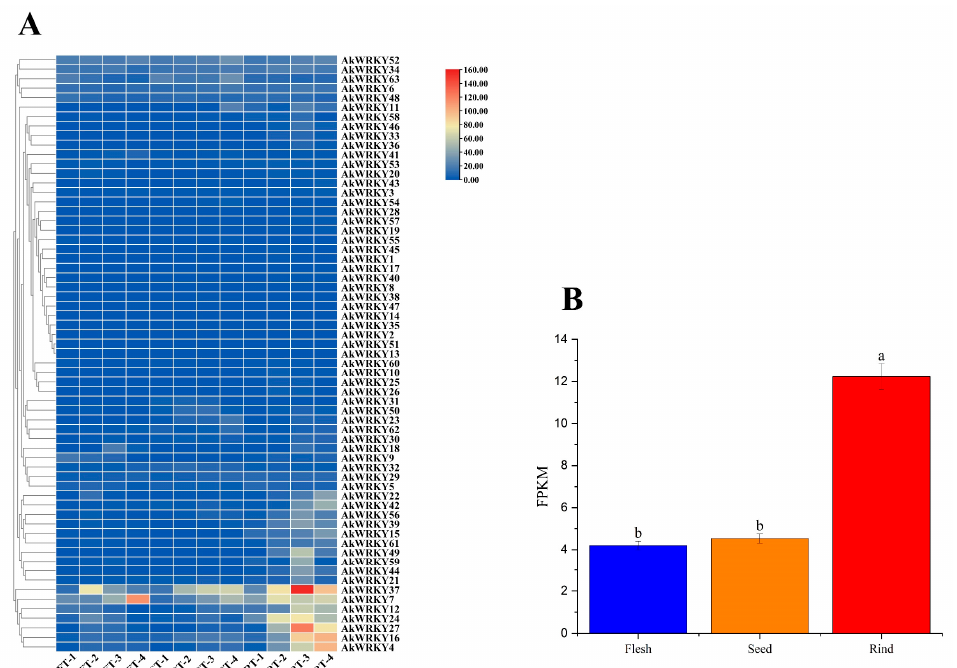
Figure 5. Expression analysis of the WRKY gene in A. trifoliata . ( A ) Heatmap of the expression of 63 AkWRKY genes at four stages in three tissues of fruit. The gradient from blue to red represents low to high expression. ( B ) Average expression of 63 AkWRKYs in three tissues. The different letters indicate significant differences in multiple comparisons.